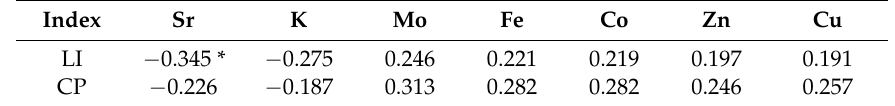
Table 7. Results of the correlation analysis of the centenarian prevalence, longevity index and trace elements and mineral levels in